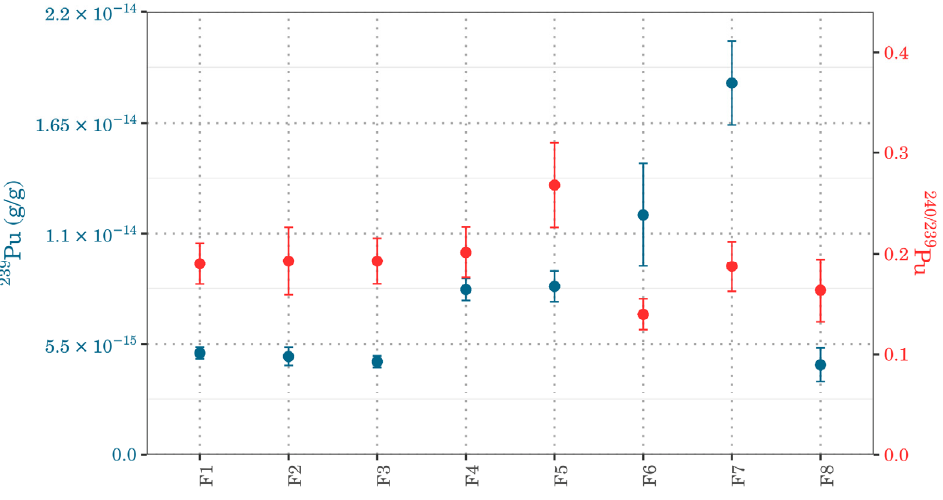
Figure 6. 239 Pu concentration (in blue, on the left) and 239/240 Pu isotopic ratio (in red, on the right) in sediments collected along the river.